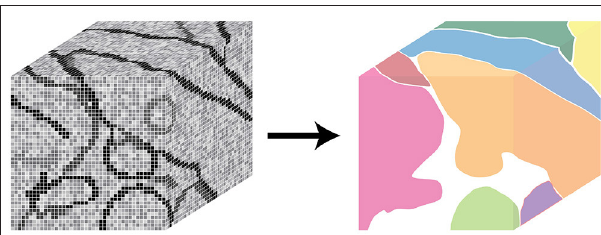
FIGURE 3 | An illustration showing annotations , composed of voxel labels (left) and how a unique annotation identifier can represent a unique object in the image data